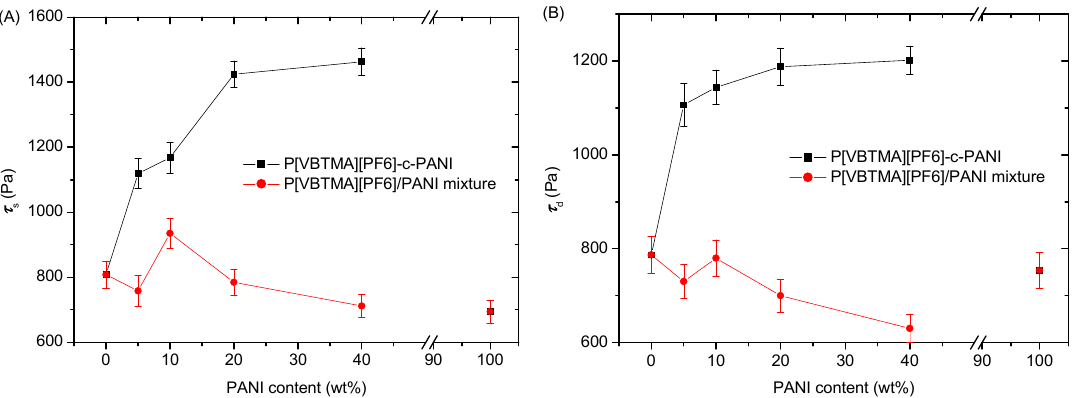
Figure 6. Static yield stress ( A ) and dynamic yield stress ( B ) as a function of PANI content for the suspensions of P[VBTMA][PF 6 ]-c-PANI and the corresponding P[VBTMA][PF 6 ]/PANI mixture at 3.0 kV/mm of electric field ( φ = 27 vol %, T = 23 °C).